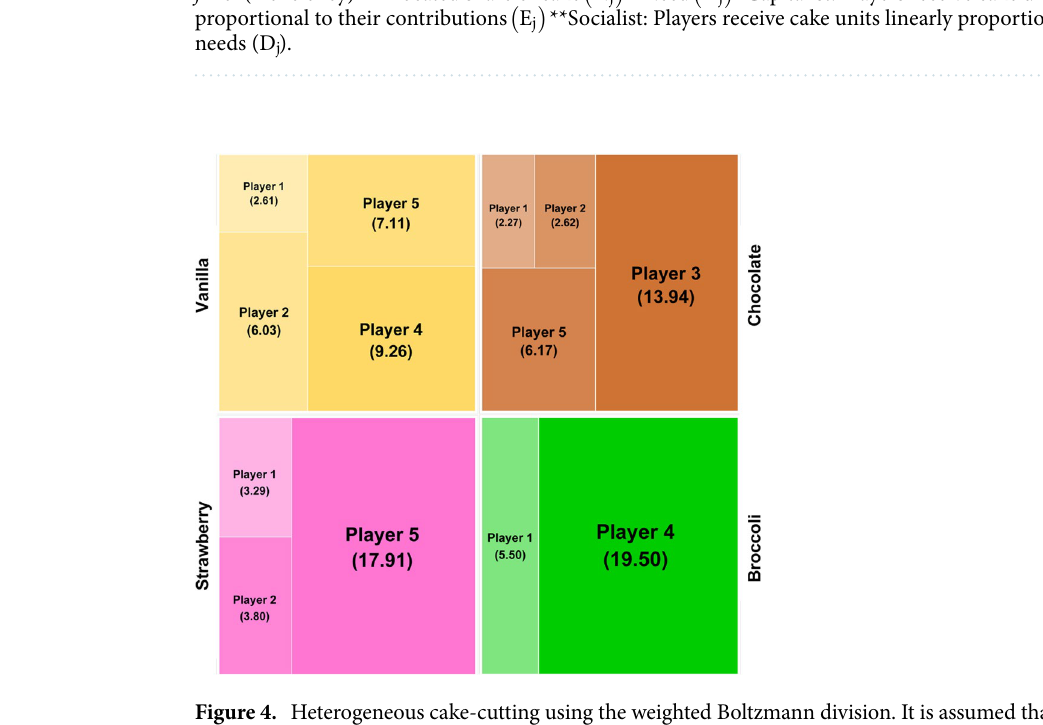
Table 1. Homogeneous cake-cutting using the Boltzmann division and proportionality (Egalitarian, Prop I (Capitalist), Prop II (Socialist)). E j = Contribution to cake production of player j D j = Need for cake of player j Def (Deficiency) = Allocated share of cake (cid:31) N j (cid:30) —Need (cid:31) D j (cid:30) *Capitalist: Players receive cake units linearly